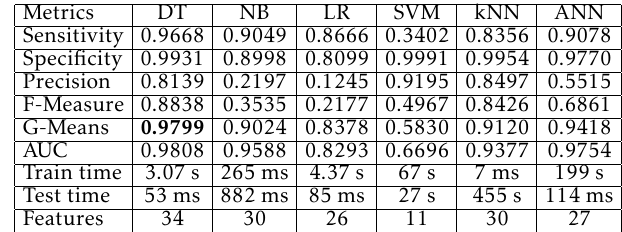
Table 13. Results of using CA-BFE algorithm on BACKDOOR.